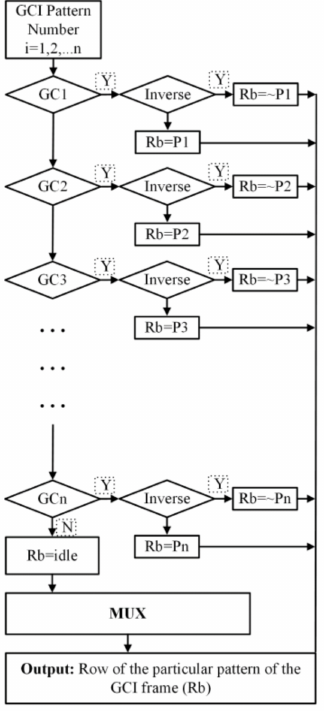
Figure 11. GCI patterns generation